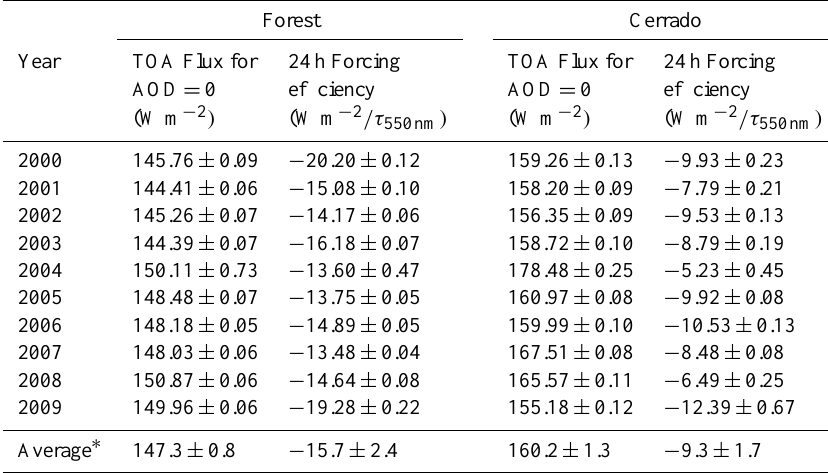
Table 4. Mean TOA shortwave flux for no aerosols and 24-h mean aerosol forcing efficiency for forest and cerrado (savannah-like) regions with their respective uncertainties.